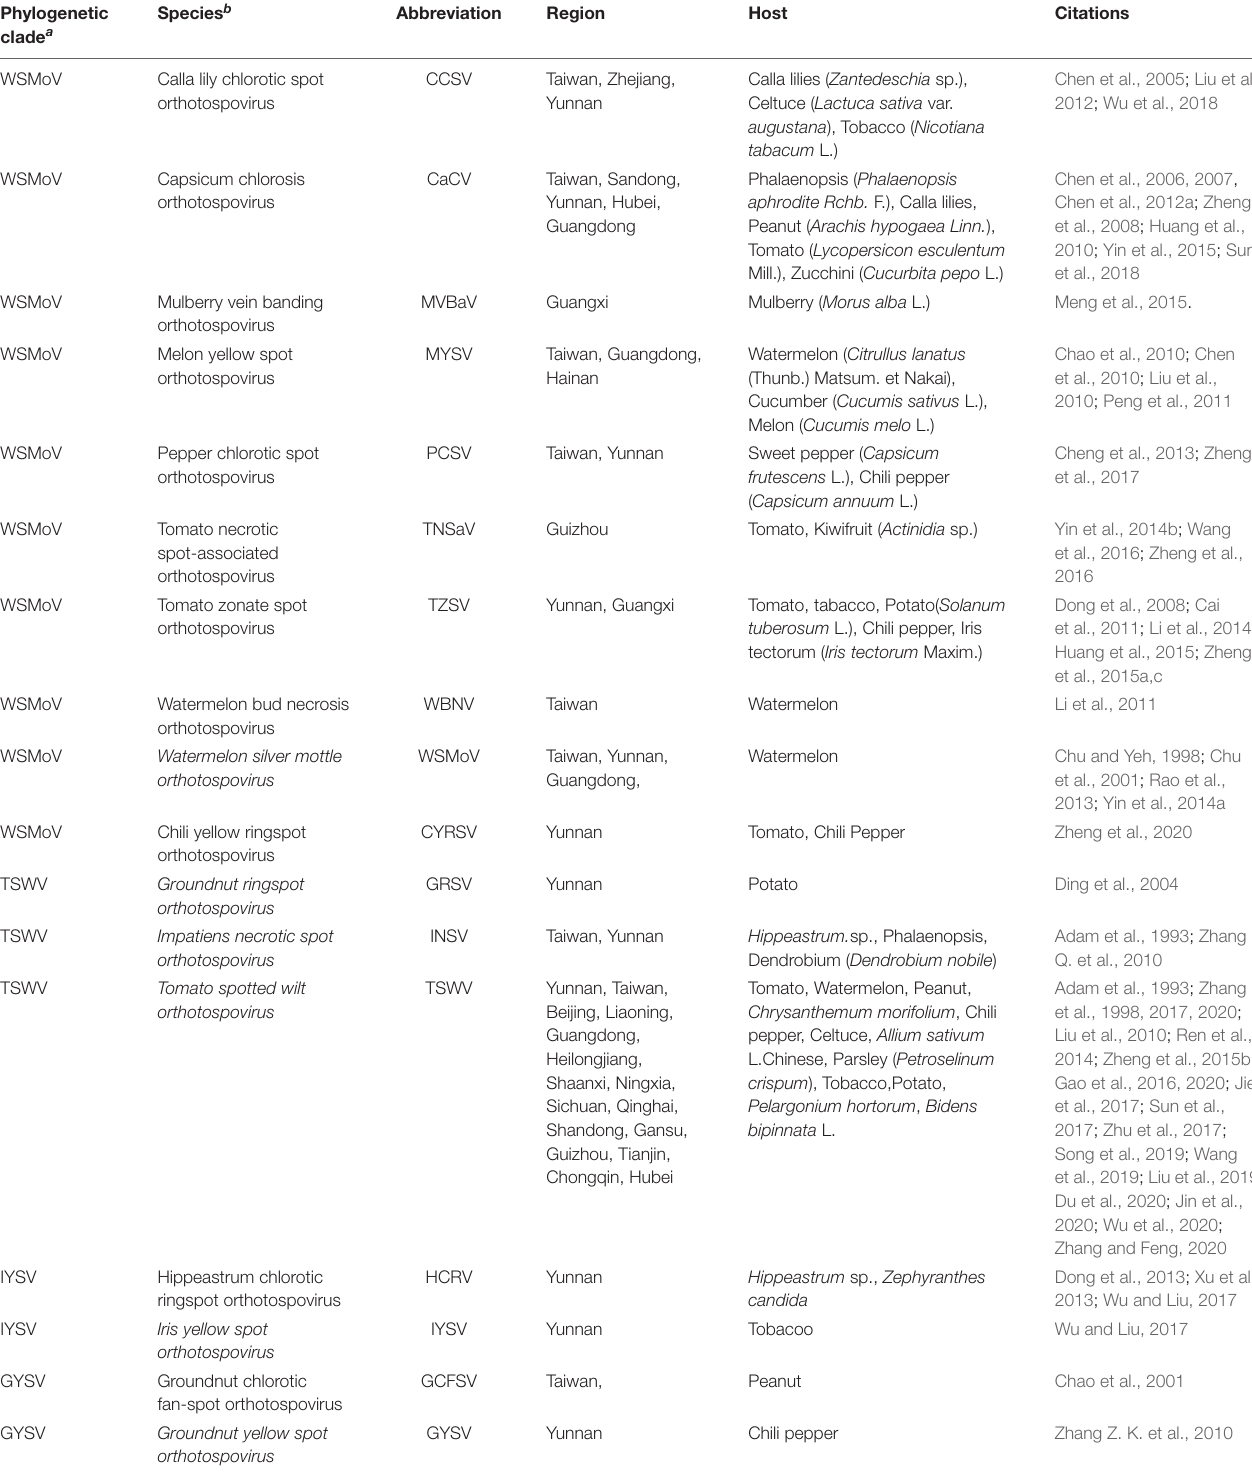
TABLE 1 | Orthotospoviruses reported by